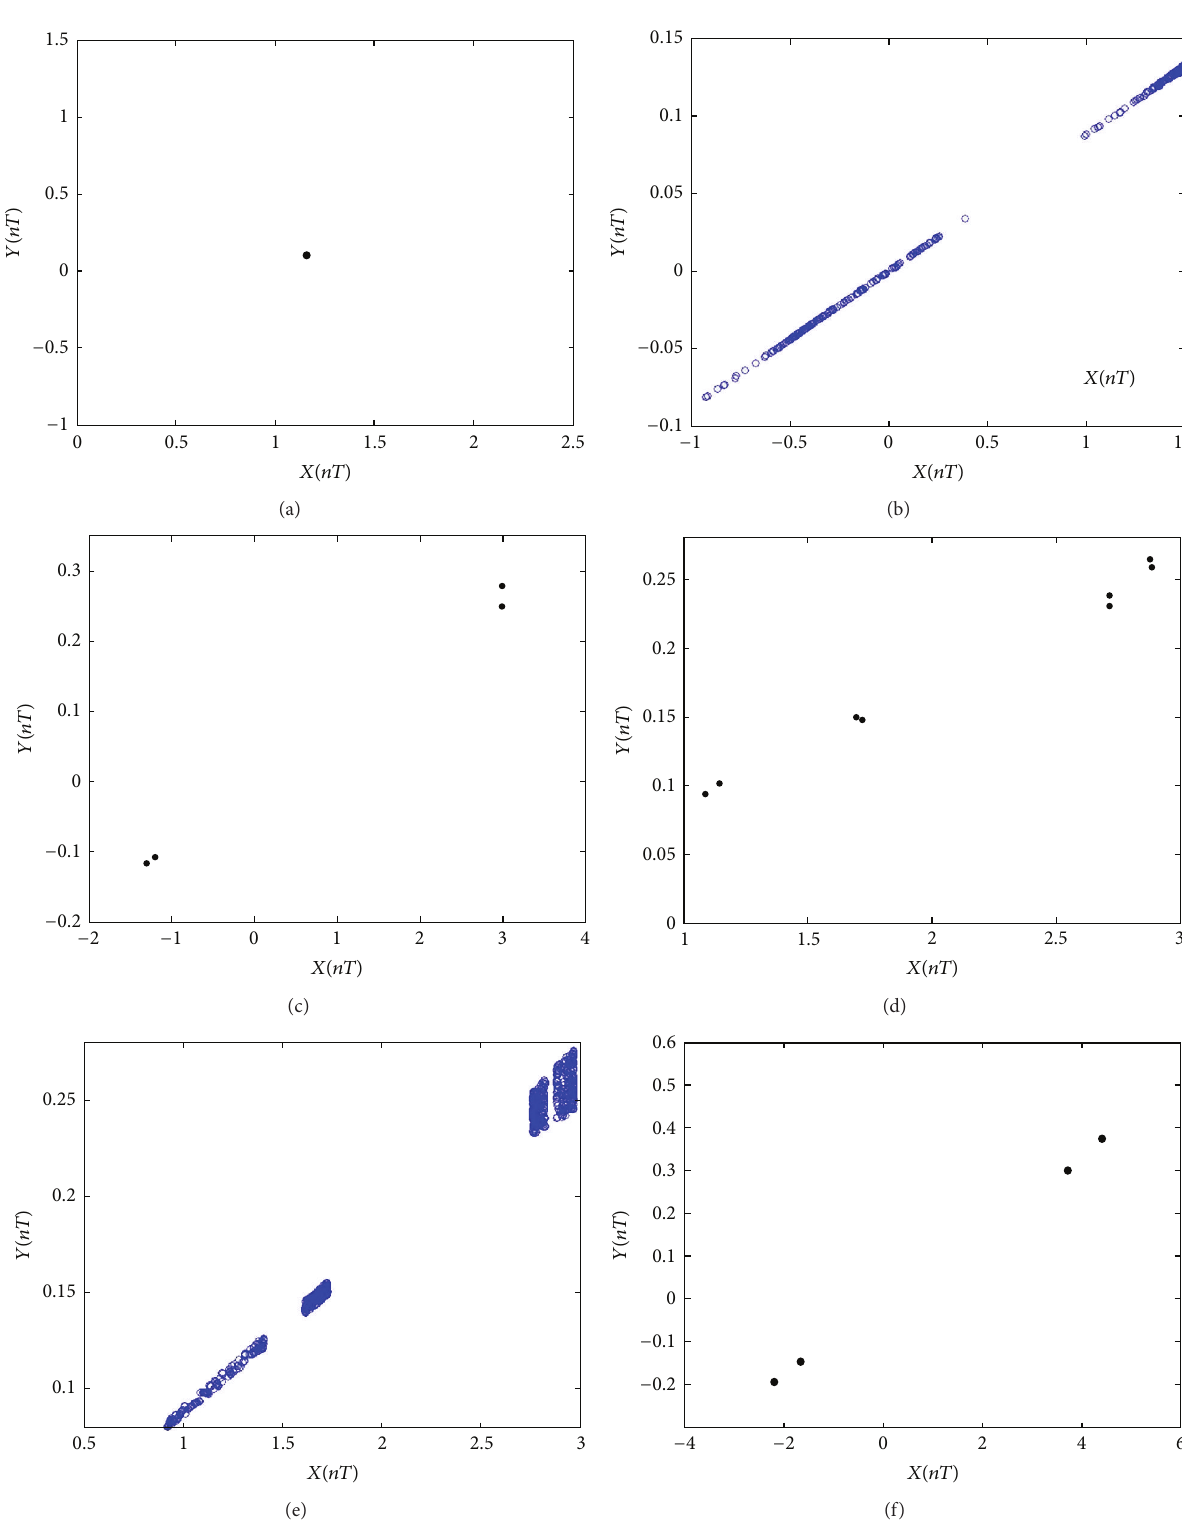
Figure 4: Poincar´e maps of coronary artery system at different values of vibrational amplitude (𝐸) : (a) 0.1, (b) 0.3, (c) 3.8, (d) 4.3, (e) 4.5, and (f)